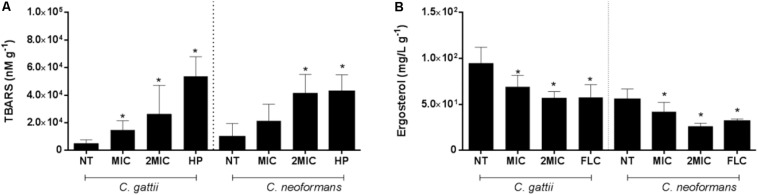
Reduction of lipid peroxidation and ergosterol content are consequences of the treatment with EAF of Xylosma prockia. Amount of TBARS in Cryptococcus gattii and Cryptococcus neoformans cells after 24 h of EAF or HP (positive controls) treatment. The results are expressed in nanomolars per gram (A). Ergosterol levels of cells from C. gattii and C. neoformans after 24 h of EAF or FLC (positive control) treatments. Results are expressed in micrograms per milliliter per gram (B). Data of these two experiments are represented as the mean ± SEM of two independent experiments in triplicate assays. An asterisk represents statistical differences between the treatments and the control (P < 0.05). EAF, ethyl acetate fraction; NT, no treatment; FLC, fluconazole; HP, hydrogen peroxide; MIC, minimal inhibitory concentration; TBARS, thiobarbituric acid-reactive substances.